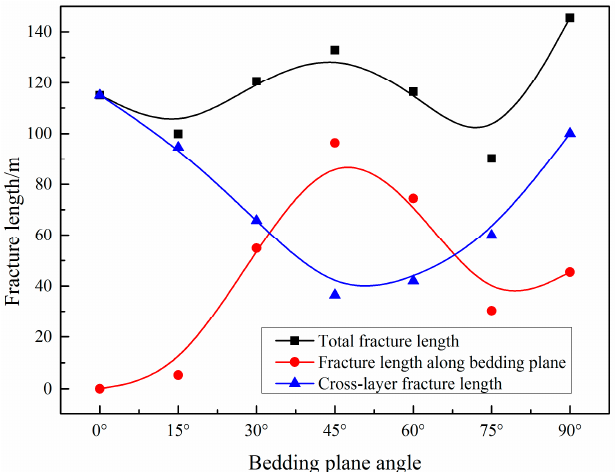
Figure 7. Fracture lengths. The lengths of bedding slip fracture was directly influenced by the BP angle. The longer the bedding slip fracture, the greater the effect of bedding on HF. At 30°, the length of cross-layer fracture was close to that of the bedding slip fracture, and the BP exerted a favorable effect.